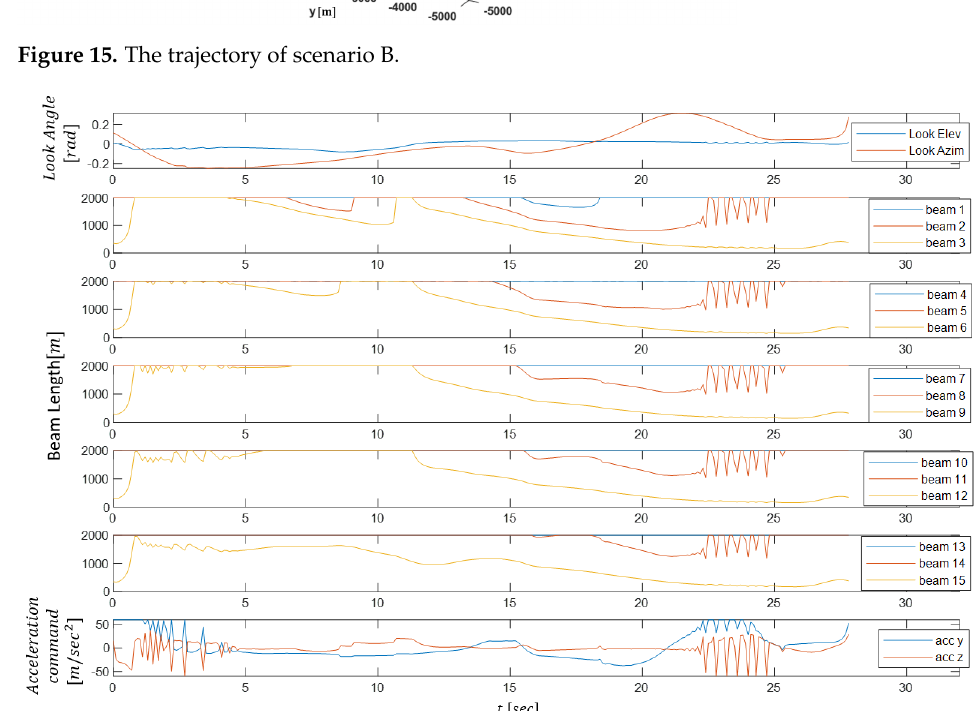
Figure 16. Trajectories of the look angle, beam length, and acceleration